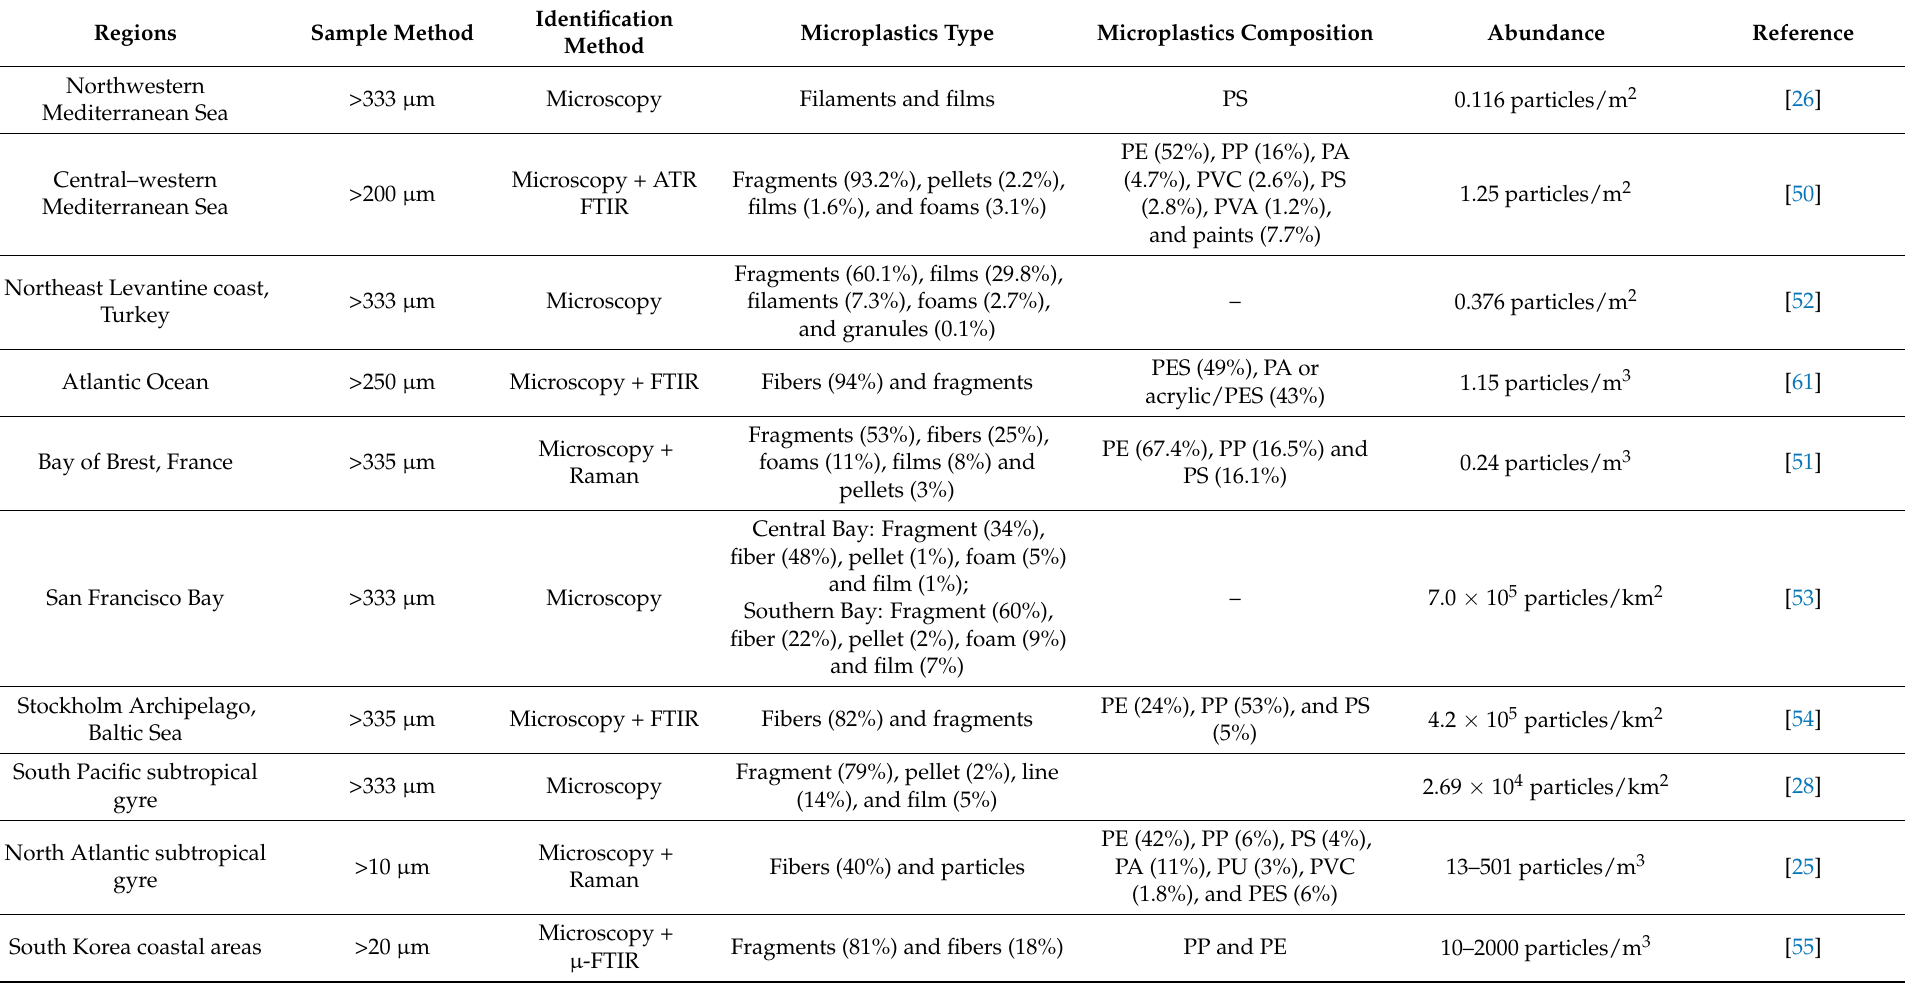
Table 1. The distribution and abundance of microplastics in global